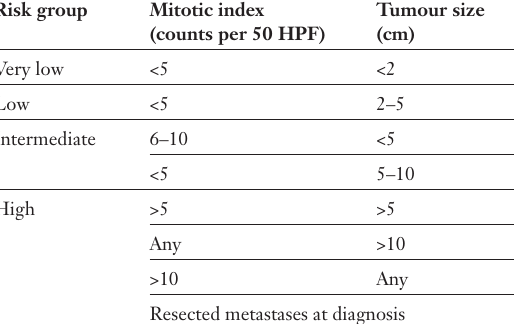
Risk assessment of primary GIST consid- ering anatomic site in addition to size and mitotic activity [33]. Data based on long-term follow-up observation of 1939 patients [72] (HPF, high power field corresponding to 5 mm 2